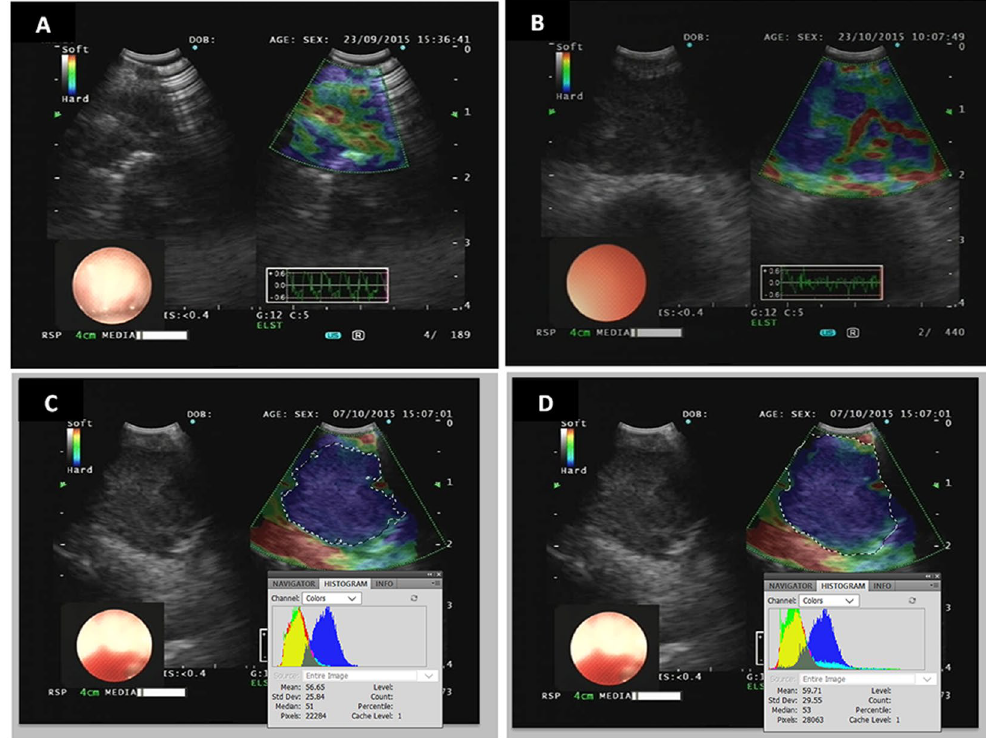
Figure 3. The representative color patterns of LNs on EBUS elastography imagings. For every elastogrpahy imaging like picture A, the LN was shown both by B mode ultrasound on the left and corresponding elastography imaging on the right. In the elastography image, the blue, green and red color indicated the hardest, medium and softest tissues respectively. ( A ) LN with BCP < 36.7%. ( B ) LN with BCP > 36.7%. ( C ) Photoshop showed the pixels of blue color in another LN, ( D ) (same patient as C ): Photoshop showed the pixels of the whole LN area. BCP was calculated by dividing the pixels of blue color in picture C with that in picture D . EBUS, endobronchial ultrasound; LN, lymph